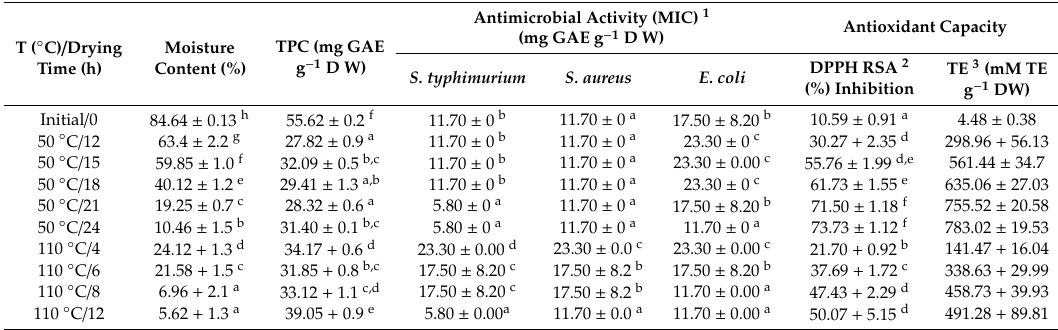
Table 3. Changes on moisture content, TPC, antimicrobial activity and antioxidant capacity during the drying process of lemon residues at 50 ◦